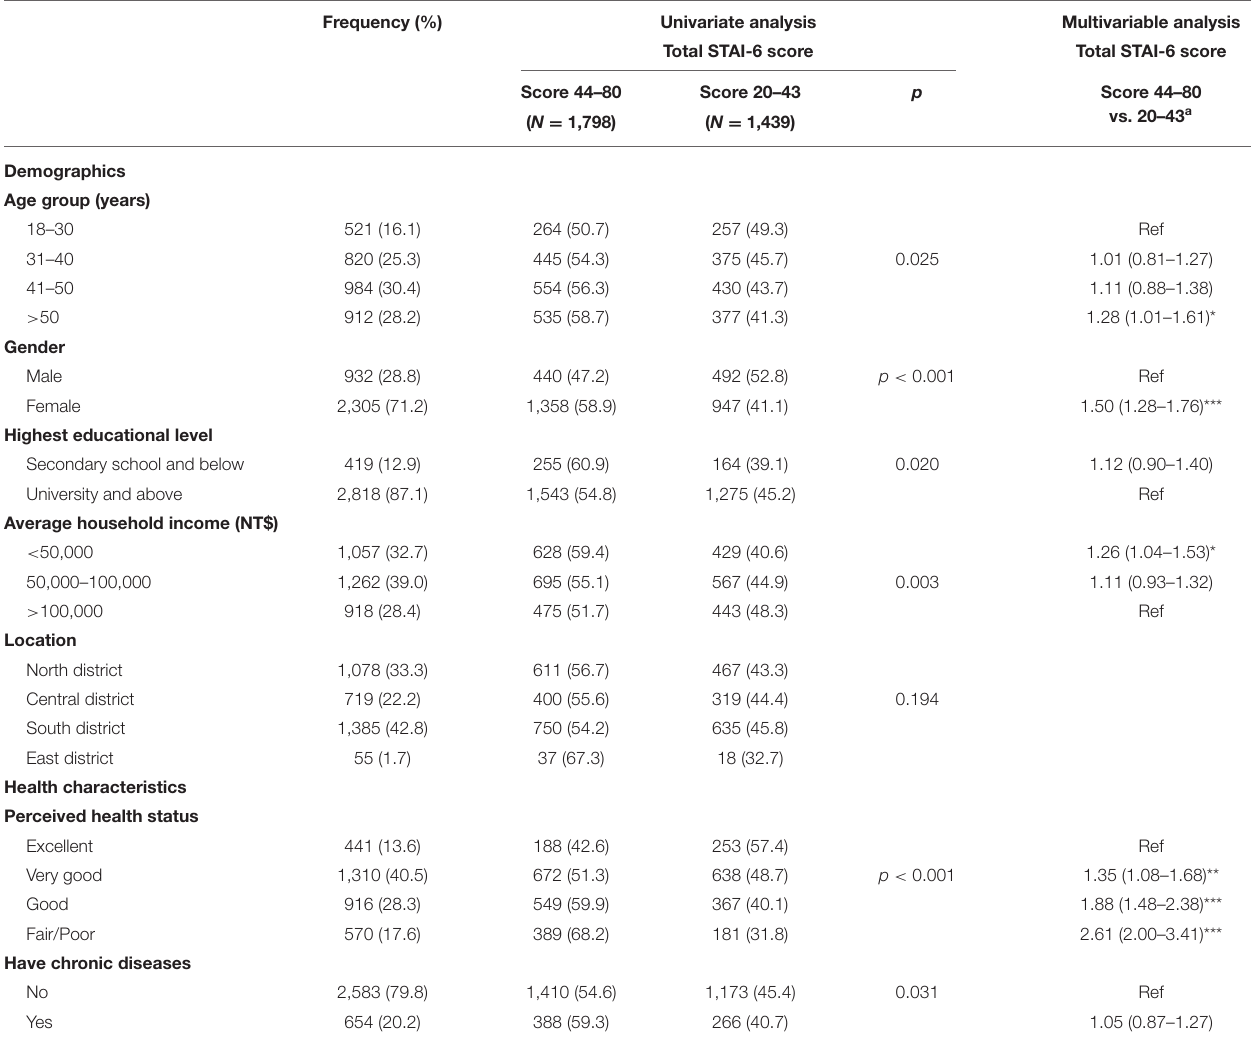
TABLE 1 | Demographic characteristics and the State-Trait Anxiety Inventory (STAI) scores ( N =